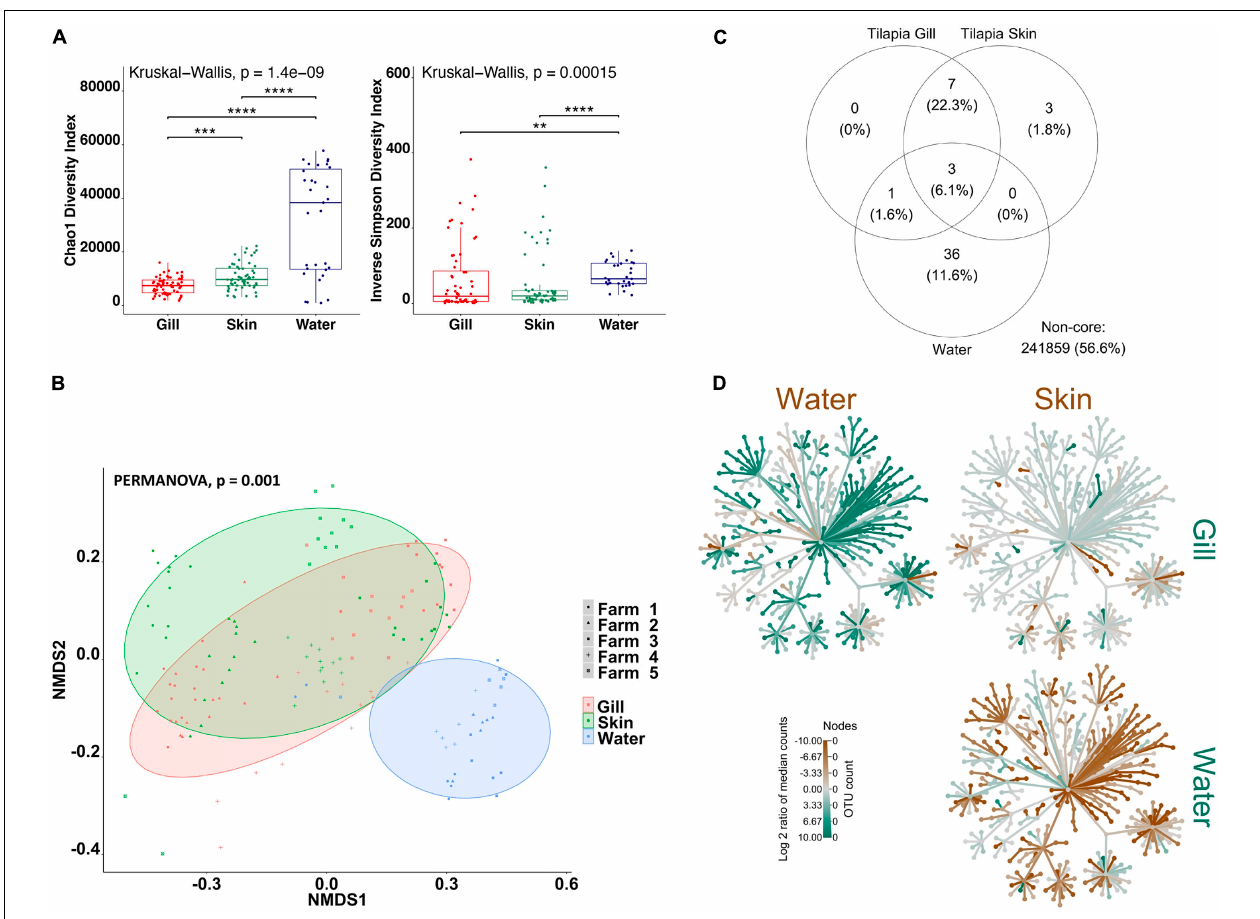
FIGURE 1 | Differential microbial communities in Nile tilapia external surfaces and pond water ( n =60 fish and n =30 water) across five farms. (A) Alpha-diversity metrics of tilapia gill and skin microbial communities and pond water. Chao1 and Inverse Simpson were significantly different (Kruskal–Wallis, p < 0.0001) in water compared with gill and skin. Dots represent each individual sample, and ** p < 0.001, *** p < 0.0001, and **** p < 0.0001. (B) Non-metric multidimensional scaling (NMDS) plots based on Bray–Curtis similarity matrix of microbial communities (permutational multivariate ANOVA (PERMANOVA), p = 0.001). The colors of the ellipses represent the three groups, and shapes represent the five farms. (C) Venn diagram of shared and unique operational taxonomic units (OTUs). The numbers of OTUs with at least 0.1% of relative abundance in 80% of the samples are displayed. Numbers in brackets represent the average relative abundance of the OTUs in that group. (D) Differential heat tree matrix showing taxa abundance variation between tilapia gill, skin, and water represented in the dataset (RA > 0.01%). The trees illustrate the pairwise comparisons between the three groups. The color of each taxon represents the log-2 ratio of median proportions of reads observed in each group. Only significant differences, Wilcox rank-sum test followed by a Benjamini–Hochberg [false discovery rate (FDR)] correction are colored. Taxa colored green represent enrichment by row (left to right) and brown by column (top to bottom).